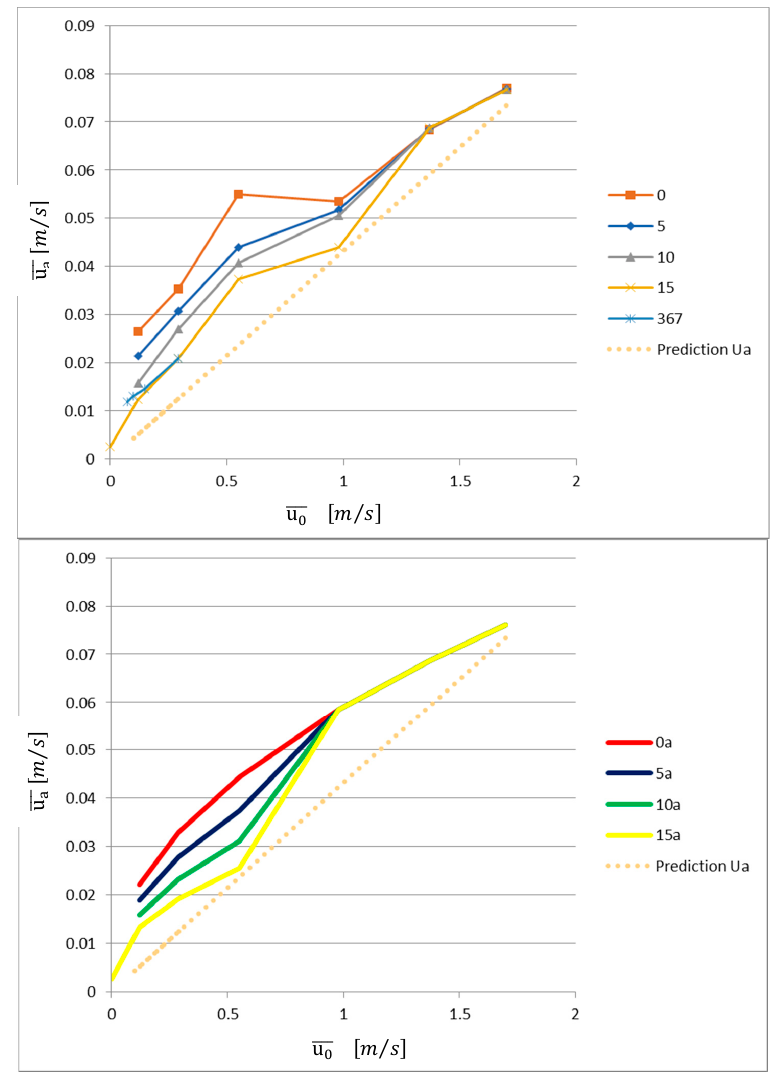
Figure 18. Comparison of Equation (25) (prediction Ua) with the test results of Section 3.1 and Equation (23).